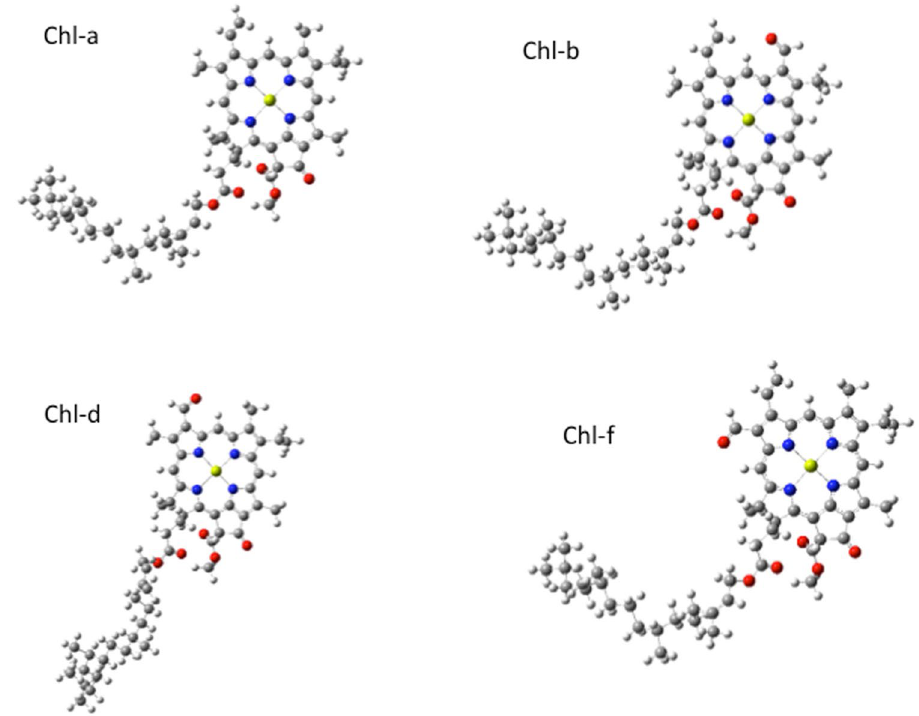
Figure 1. Optimized geometry for chlorophyll ( a , b , d , and f